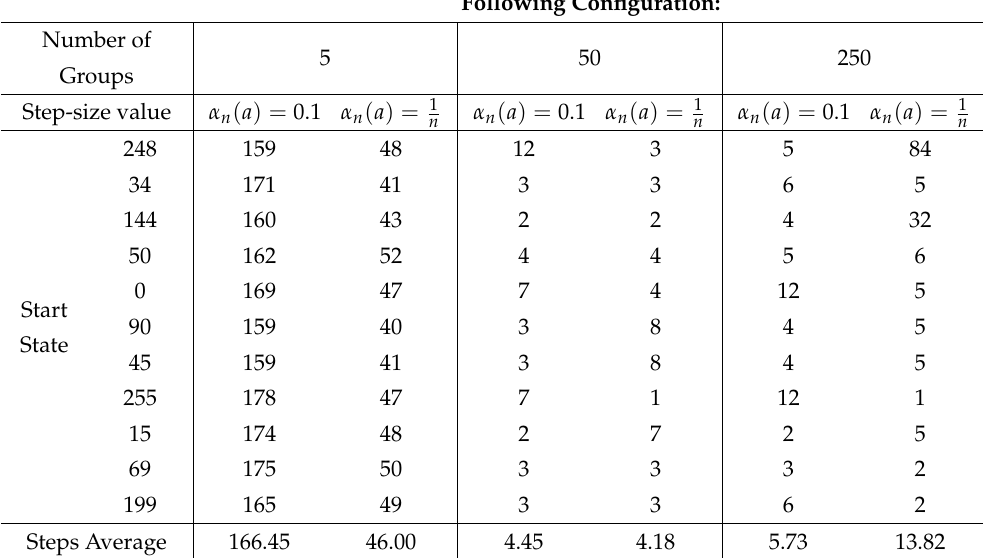
Table 9. Effect of state grouping on training performance when inference was performed using the MVS